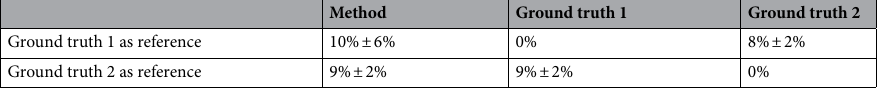
Table 1. Comparison between leakage fluorescence intensity values obtained from the method and from the ground truths. Each row corresponds to a ground truth used as reference, while each column indicates the agreement between the respective fluorescence intensity obtained and the reference values.